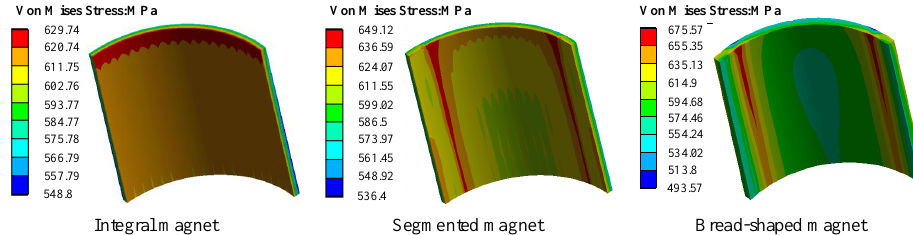
Figure 3. Comparison of Von Mises stress on the sleeve of different SPM rotor